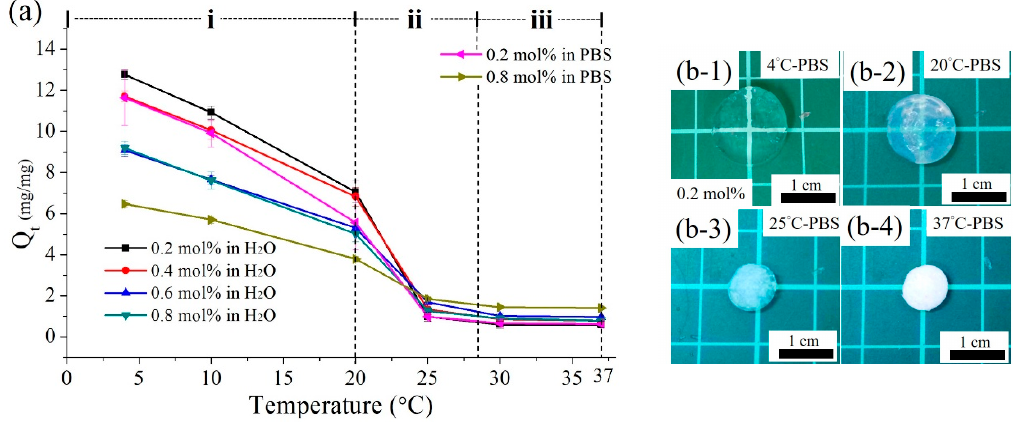
Figure 8. ( a ) Deswelling ratios of poly(MEO 2 MA) hydrogel samples were measured as a function of the temperature in Milli-Q water and PBS solution. ( b ) Optical images of the poly(MEO 2 MA) hydrogel, crosslinked with 0.2 mol % of DEGDMA, corresponding to the temperature changes between 4 °C and 37 °C.